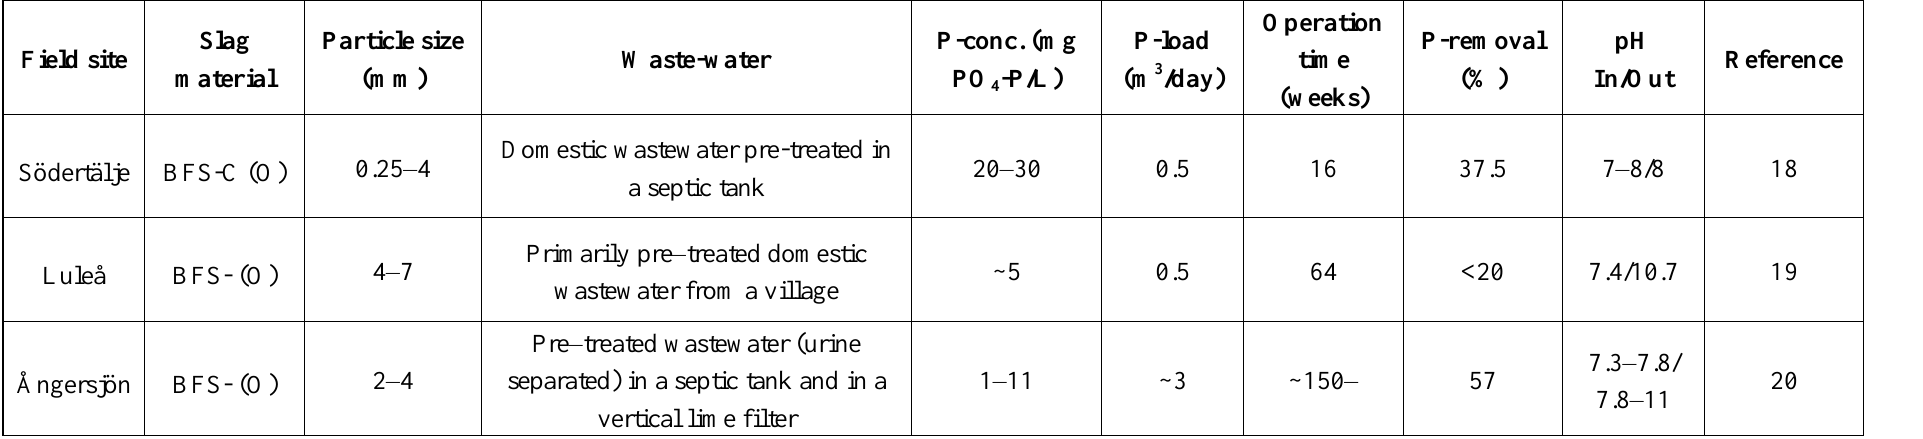
Table 4. Results from field trials using blast furnace slag